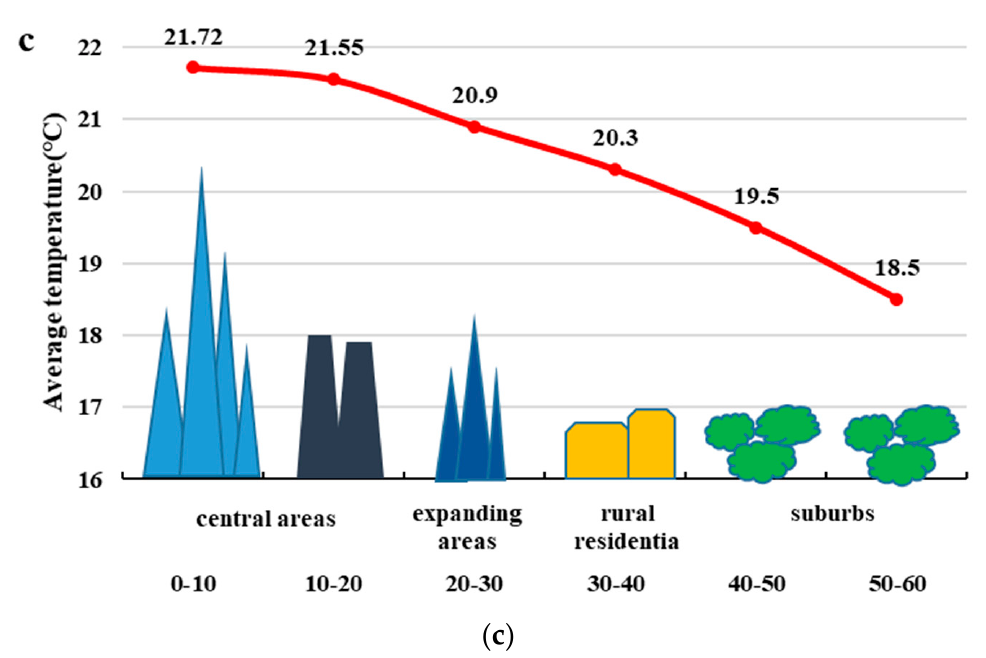
Figure 6. ( a ) Land-use of Beijing in 2015. Detail of legend refers to Table S1. ( b ) Average surface temperature in Beijing during 2000–2015, varying from 9.6 to 22 °C. ( c ) UHI effect mode based on land-use and surface temperature of Beijing; classification of x-axis based on the circles of ( a ), the value of y-axis calculated by the circles of ( b ).